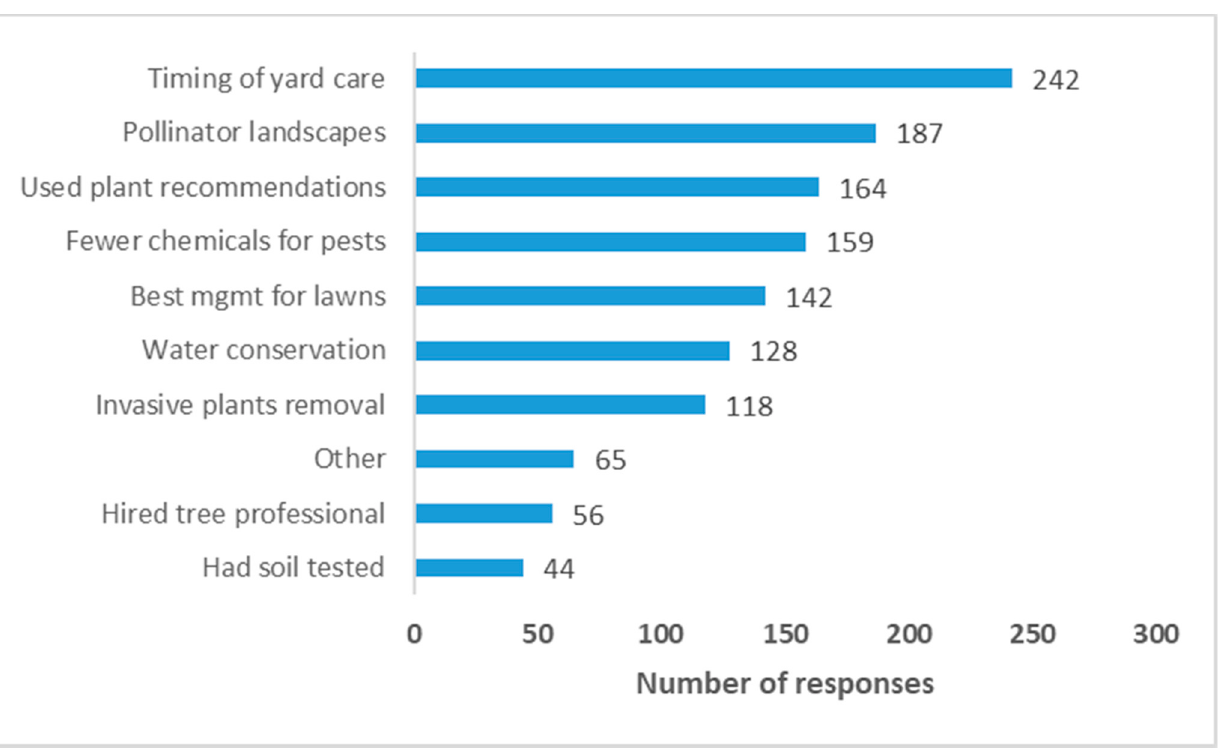
Figure 2. Changes adopted by listeners when answering the question: “Which of the following changes have you made since listening to the WCCO Smart Gardens show?” (check all that apply).